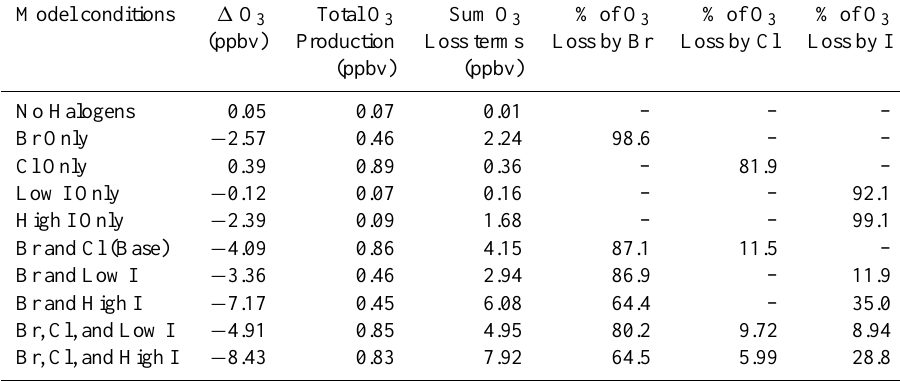
Table 6. Fraction of ozone depleted by each halogen calculated for mid-day of 29 March via Eq. (4). “Br and Cl” is the Base Model. Model